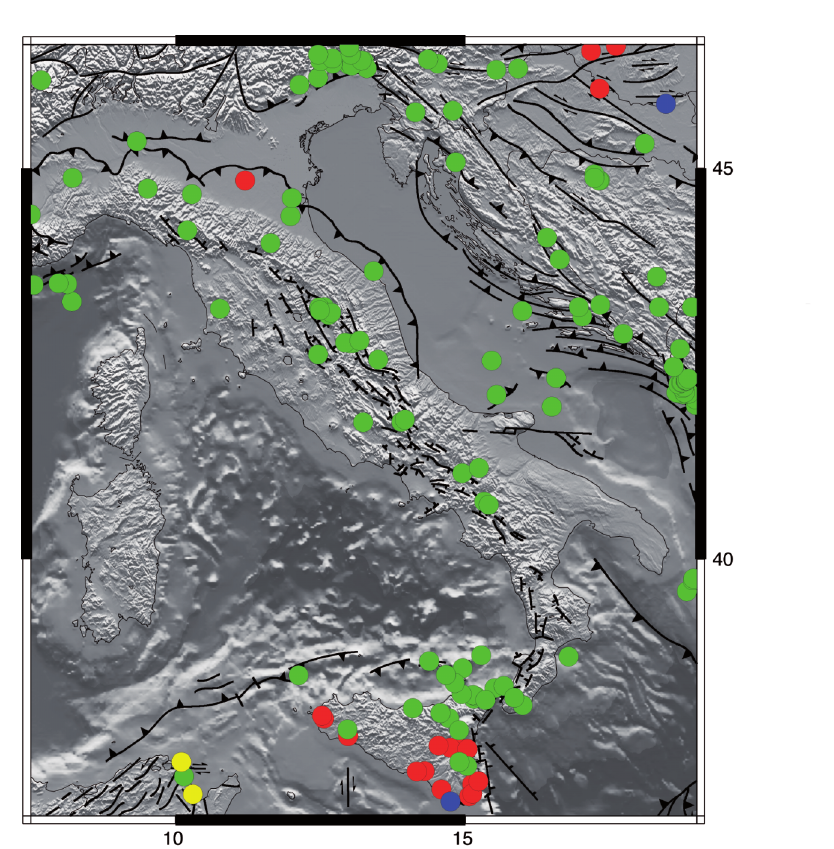
Fig. 3. Map showing the data of the first version of the World Stress Map (Zoback, 1992) for the Italian region. Different colours indicate different kinds of data. Green: focal mechanisms, composite, averaged or of a single earthquake. Red: borehole breakouts. Blue: overcoring data. Yellow: geologic fault-slip data (inversions or pa- leo-focal